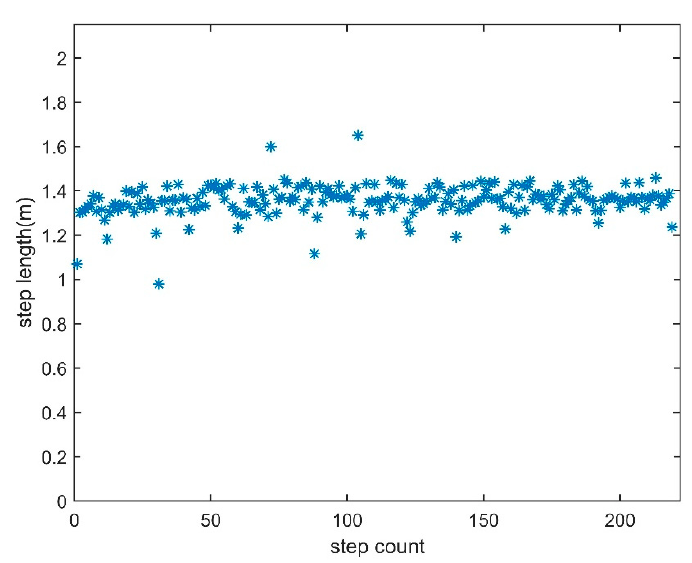
Figure 9. Experimental results for student 6.